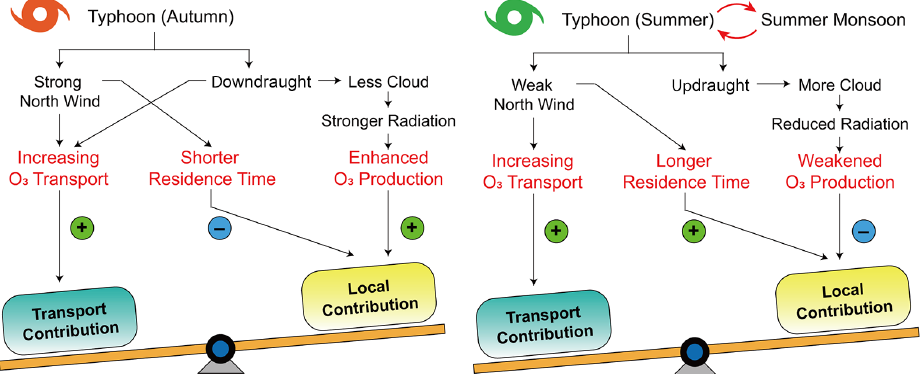
Figure 11. The summary of the causes of O 3 pollution in the PRD under typhoon influence in autumn (left) and summer